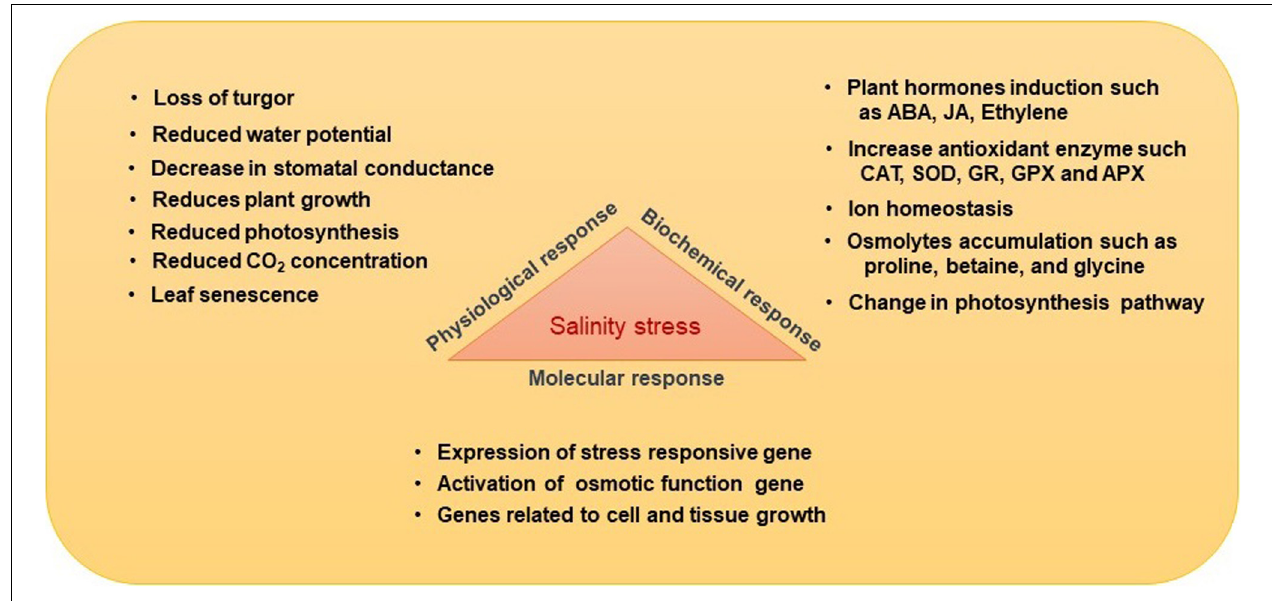
FIGURE 1 | Effects of salinity stress on different plant attributes.